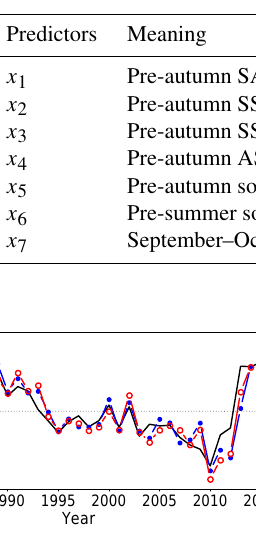
Figure 17. The temporal variation of measured (black) WHD NCP anomaly from 1980 to 2015, MLR (blue) and GAM (red) simulative WHD NCP anomaly, which was composed of cross fitted series from 1980 to 2013 and predicted values in 2014 and